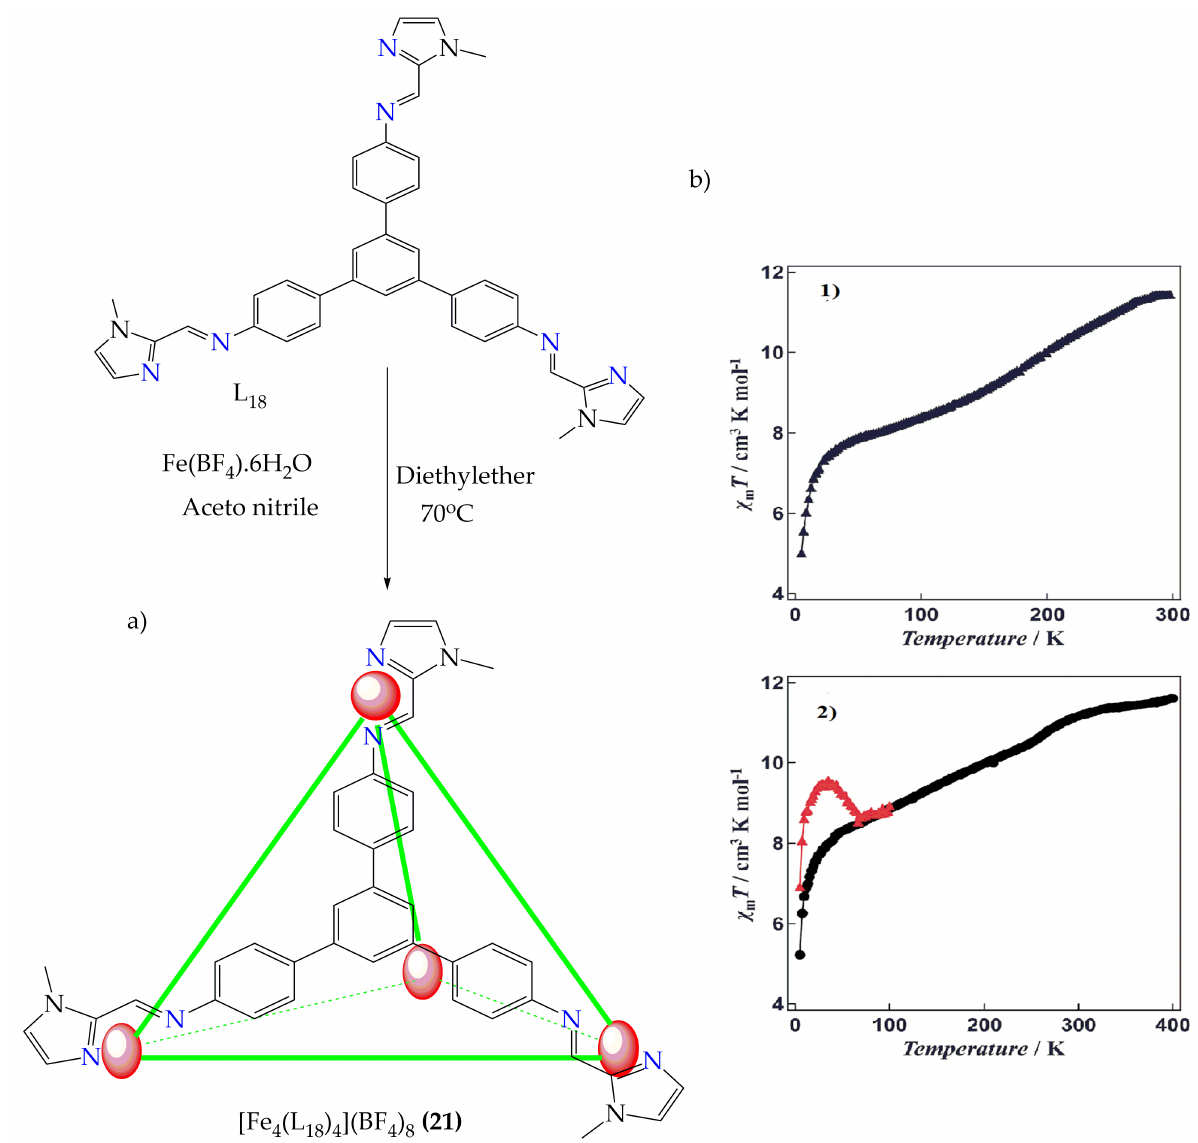
Figure 15. ( a ) Complex cation structure of 21 (red spheres = Fe II centers, green = L 19 ); ( b ) χ m T vs. T plots for b (1) solvated 21 .16MeCN, the sample was measured in the temperature range between 5 K and 300 K and b (2) non-solvated 21 compound. Reproduced from [99]; Published by Royal Society of Chemistry,